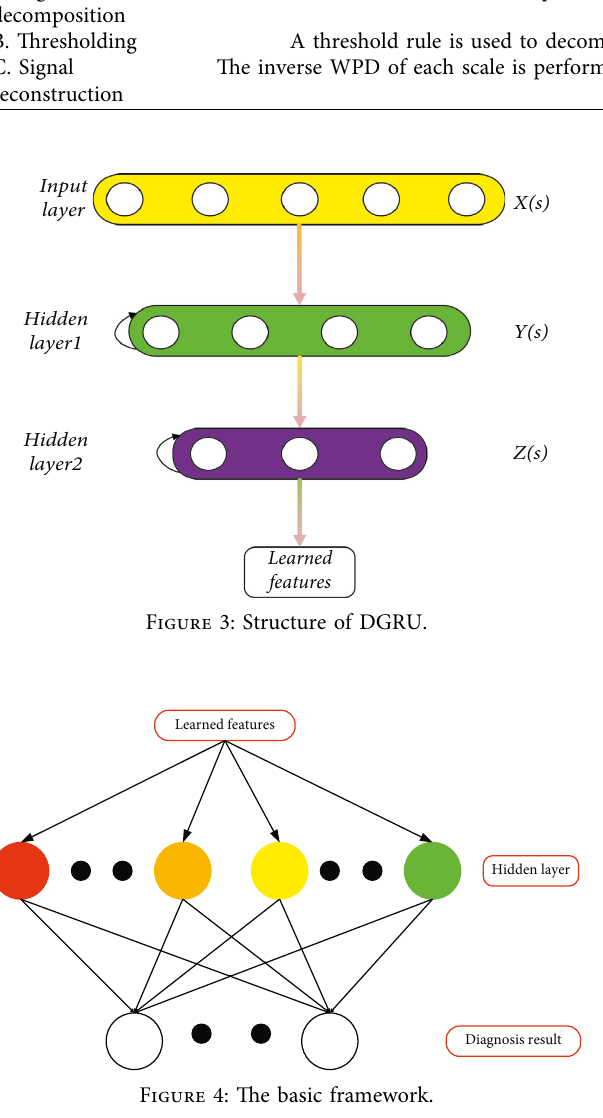
Figure 4: The basic framework.